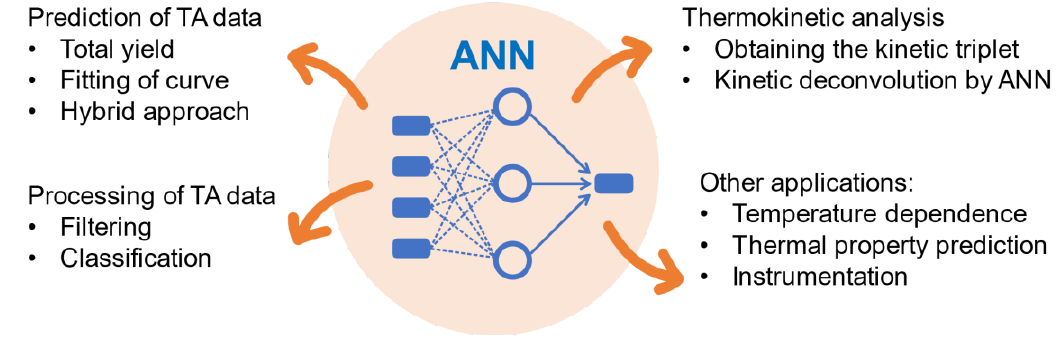
Figure 2. Logical scheme of the present review. Several aspects of using artificial neural networks (ANN) for thermal analysis (TA) studies are indicated to be discussed in main text.